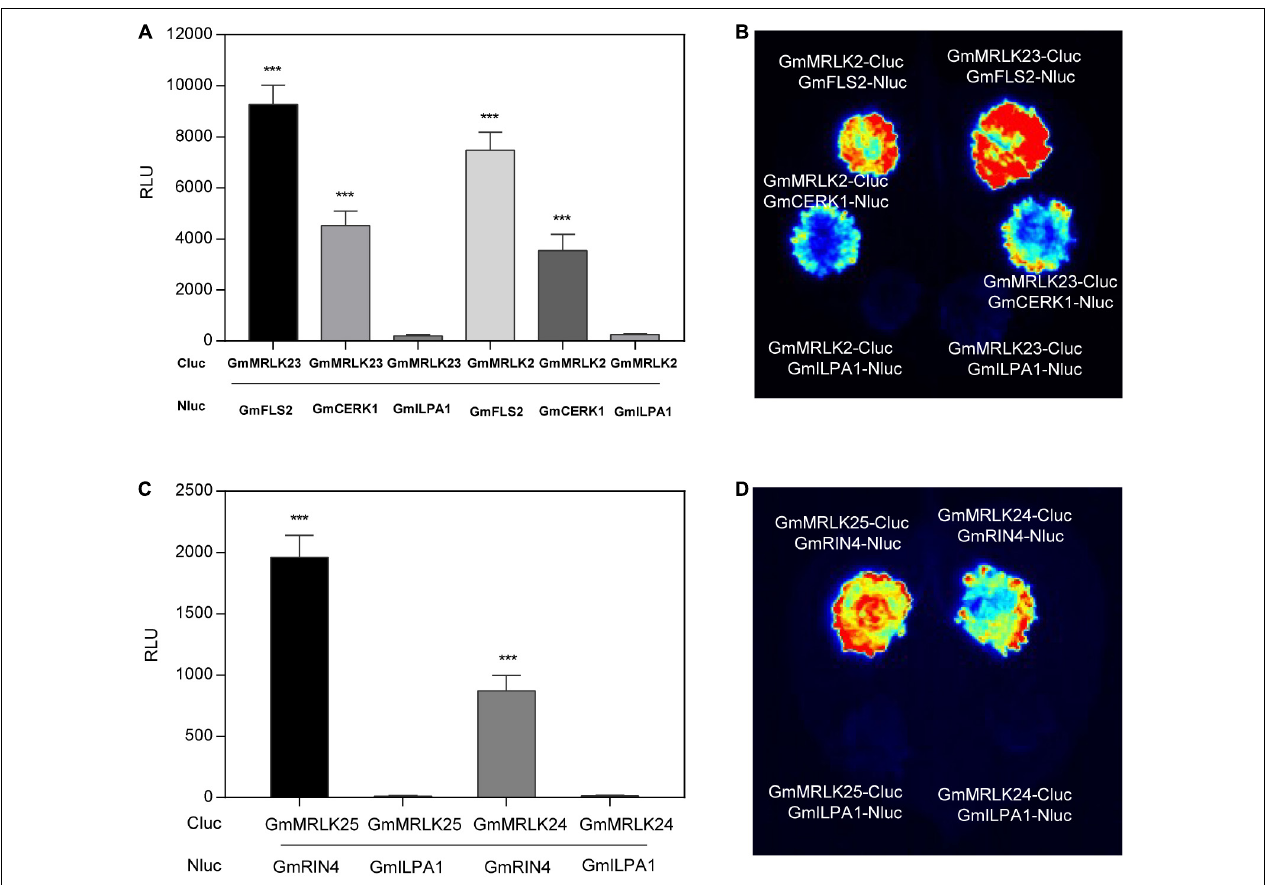
FIGURE 7 | GmMRLKs are probably involved in plant immune receptor complexes. (A,B) GmMRLK2 and GmMRLK23 interaction with GmFLS2 and GmCERK1. The indicated Nluc and Cluc constructs were expressed in N. benthamiana by Agrobacterium -mediated transient expression for 2 days, and subjected to luciferase complementation image (LCI) assays. The protein interaction intensity was showed by measuring relative luminescence unit (RLU) using luminometer (A) or by CCD imaging (B) . GmILPA1 was used as a negative control. (Mean ± SD, n ≥ 8, student’s t -test; *** p < 0.001). (C,D) GmMRLK24 and GmMRLK25 interaction with GmRIN4. The indicated Nluc and Cluc constructs were expressed in N. benthamiana by Agrobacterium -mediated transient expression for 2 days, and subjected to LCI assays. The protein interaction intensity was showed by measuring RLU using luminometer (C) or by CCD imaging (D) . GmILPA1 was used as a negative control. (Mean ± SD, n ≥ 8, student’s t -test; *** p <